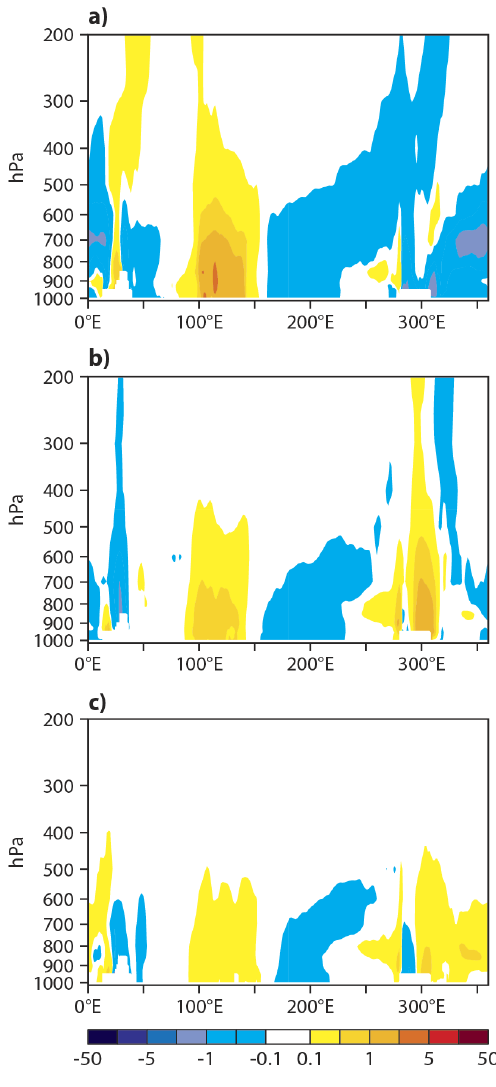
Figure 11. The same as Fig. 9 but for NO x in ppb.